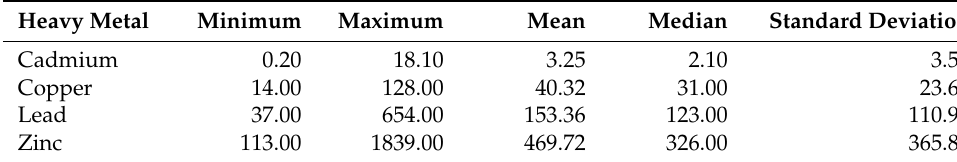
Table 2. Heavy metal concentration (ppm) statistics of Meuse data